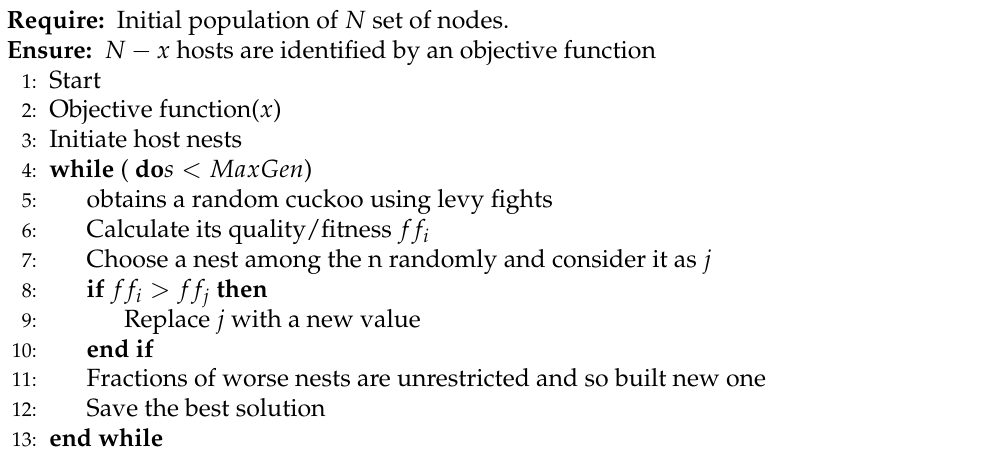
Algorithm 1 Cuckoo Search